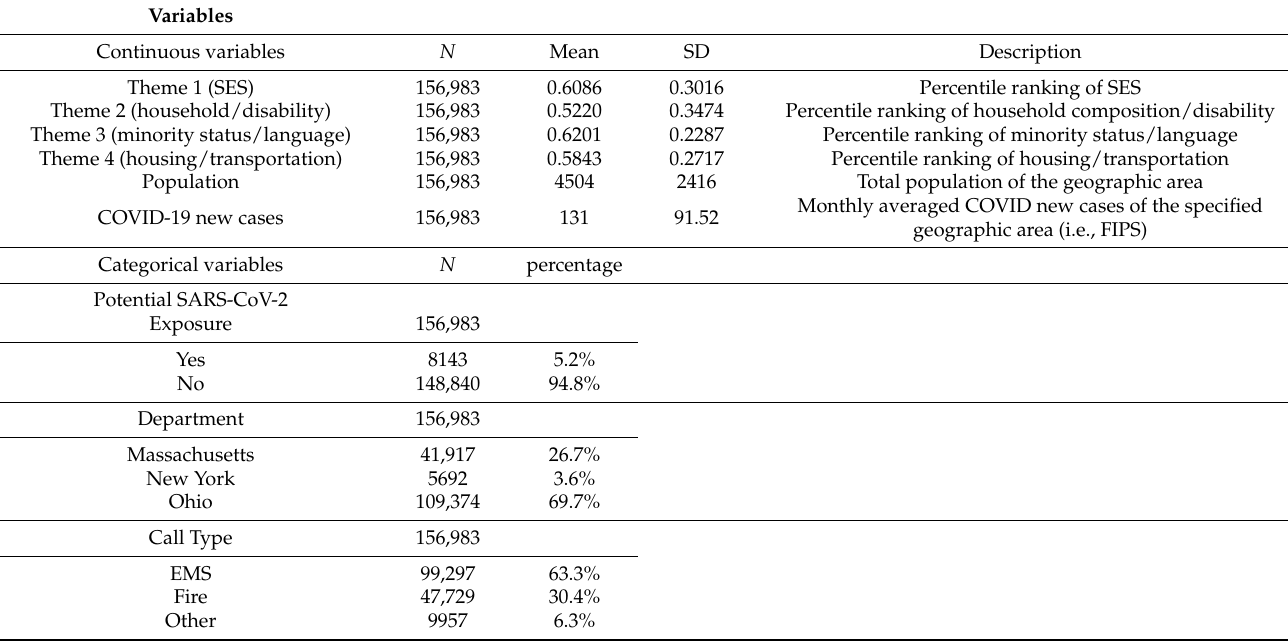
Table 2. Descriptive